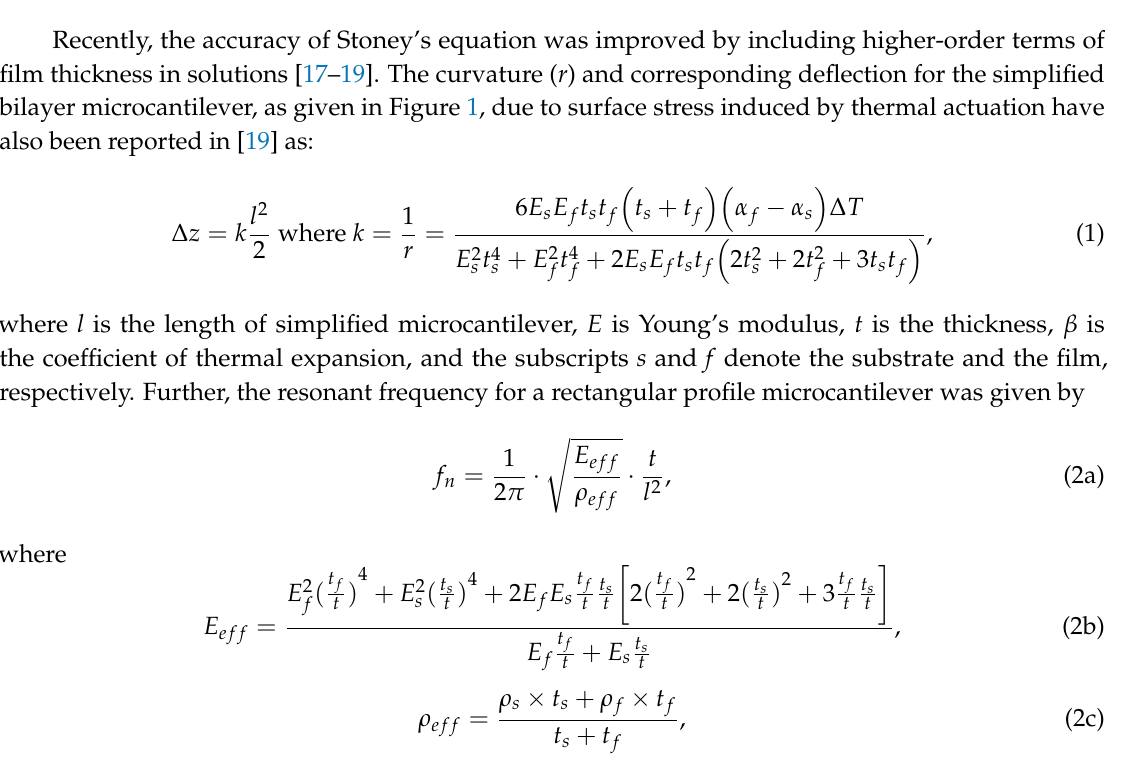
Figure 1. Schematic representation and cross section of simplified Si 3 N 4 /Au composite beam.